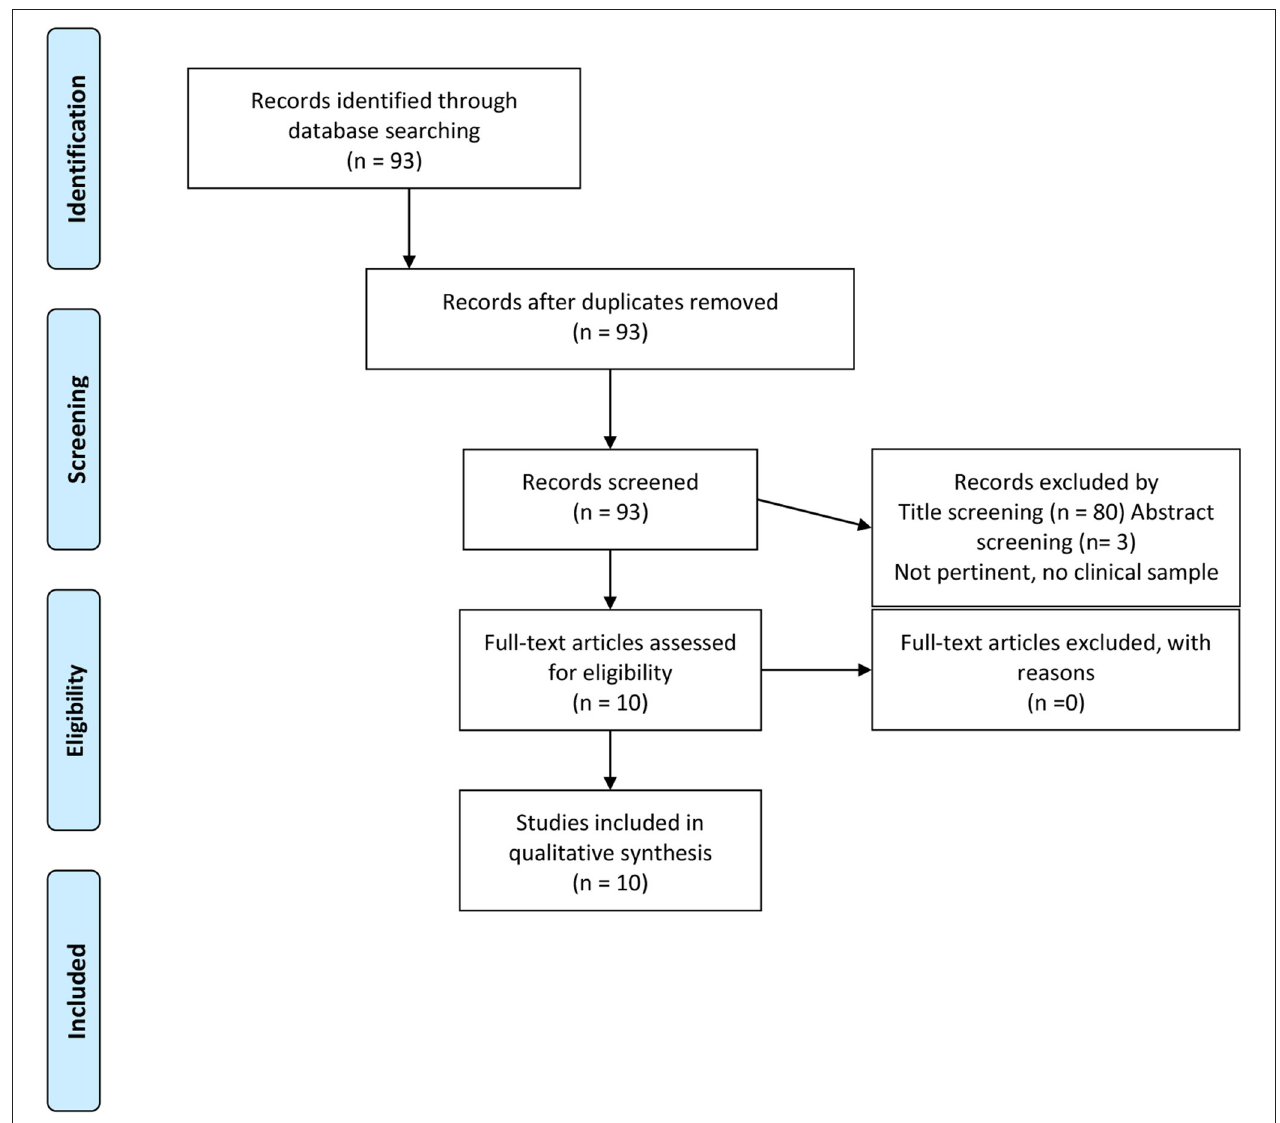
FIGURE 1 | PRISMA 2009 flow